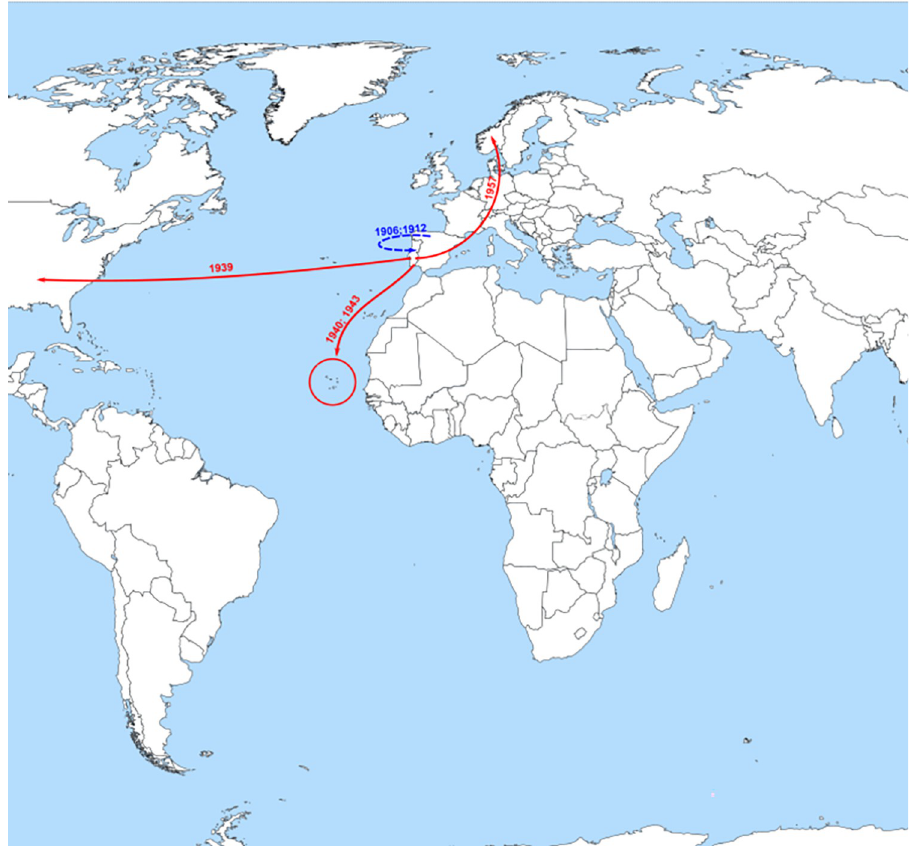
Fig 5. Probable major dispersal pathways of HBV/E as estimated by phylogeographic analysis. The dashed blue arrows represent probable routes of introduction HBV/E in Portugal. The solid red arrows represent the probable dispersion paths of HBV/E from Portugal towards other countries. This figure is a derivative of “World map blank with blue sea.svg” licensed under the Creative Commons Attribution-Share Alike 4.0 International, modified with the addition of dates, dashed blue and solid red